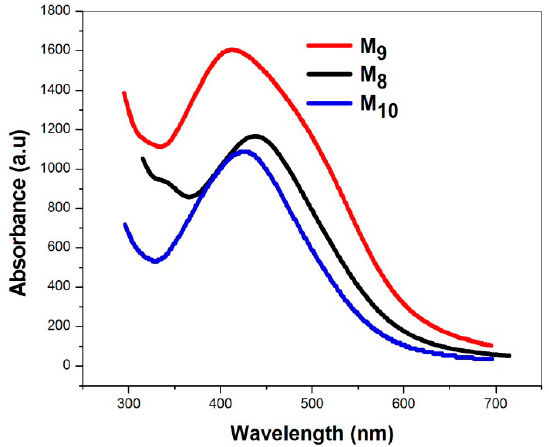
Figure 5. UV-Vis spectra of AgNPs (M 8 ), of AgNPsmw (M 9 ) and of AgNPsmw after two months of storage (M 10 ).